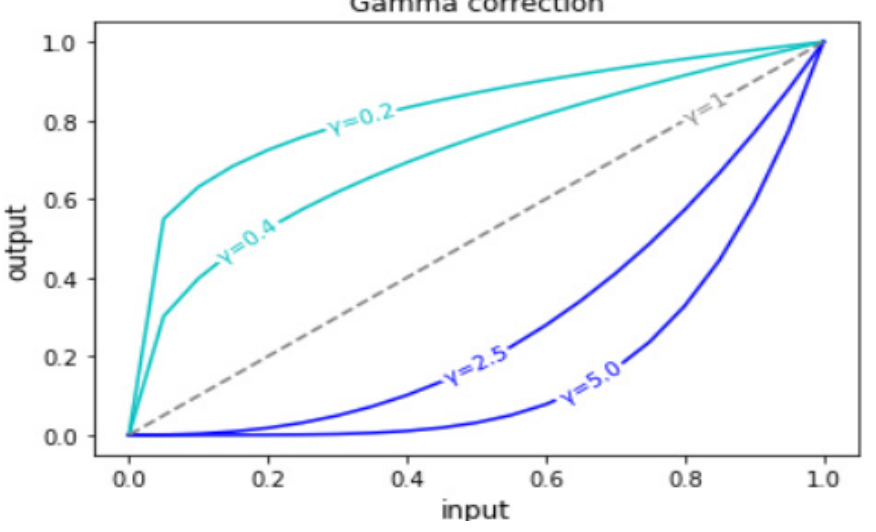
. Figure 5. Gamma Correction for different values of γ 𝛾𝛾